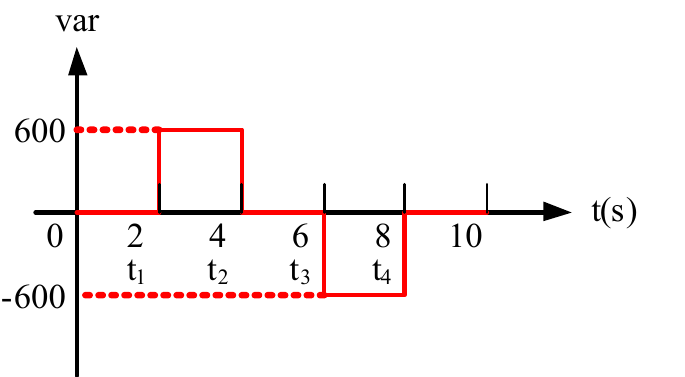
Figure 24. Implementation scenario: sequence diagram of reactive power command.